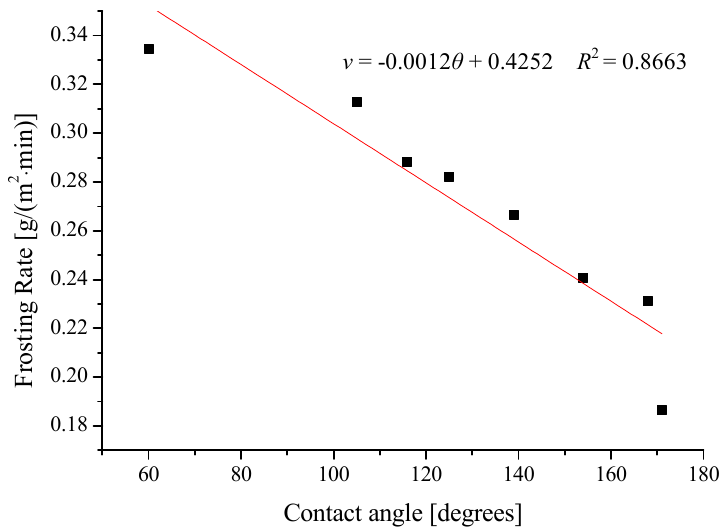
Figure 9. Variations of average frosting rate with the contact angles.